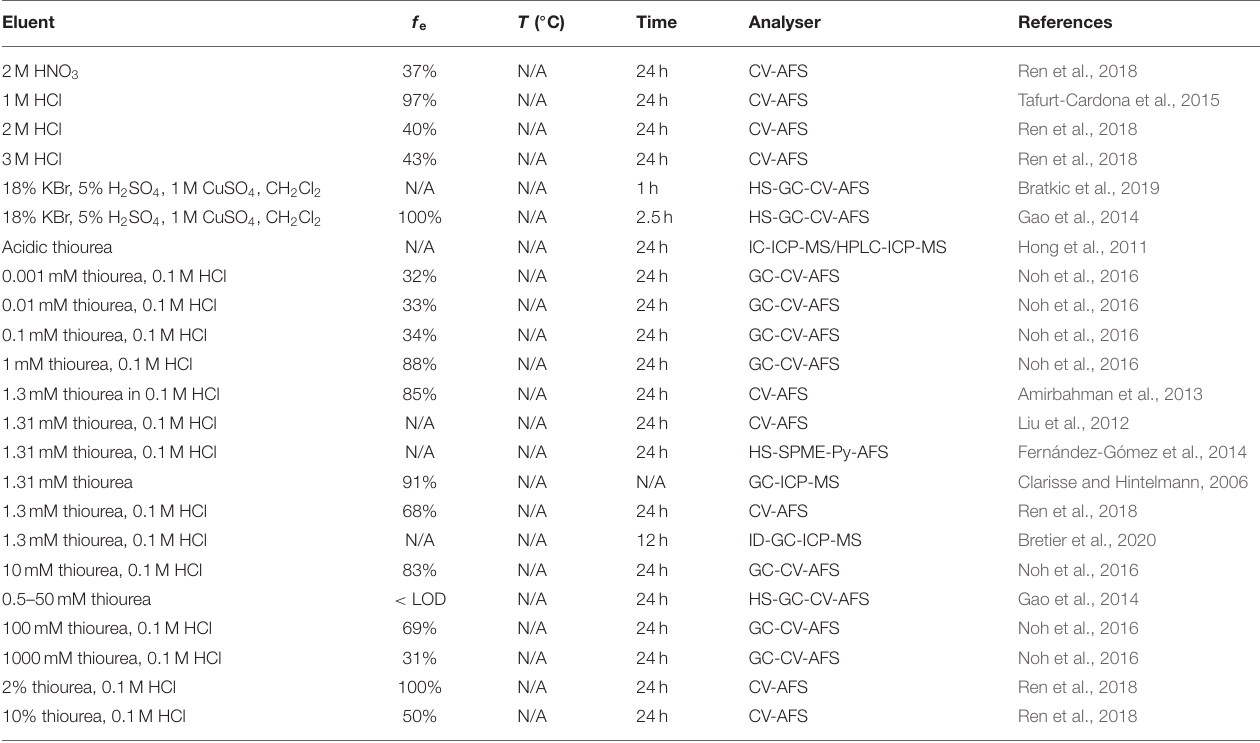
TABLE 6 | Extraction procedures for dissolved